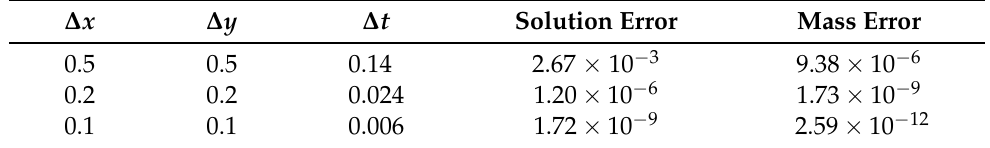
Table 3. The solution error and the mass relative error for different step